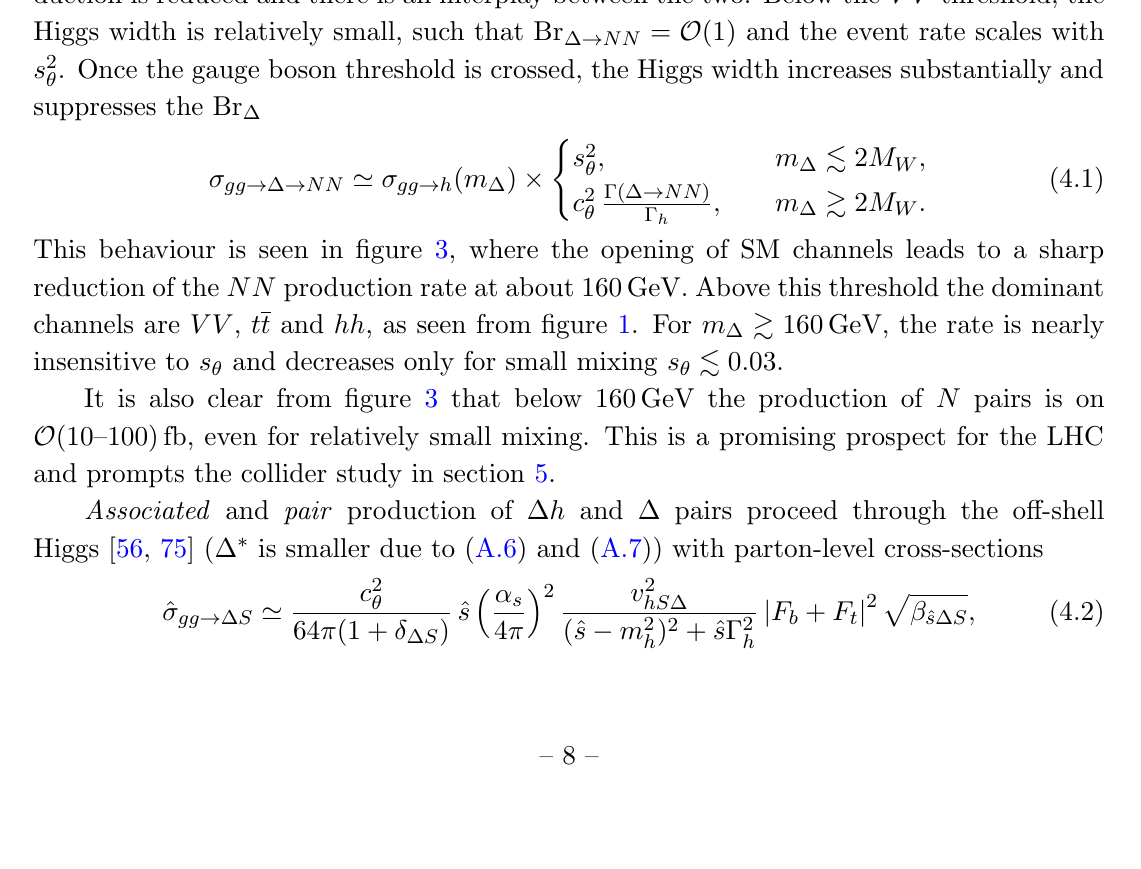
Figure 3 . Left: production cross-section of heavy Majorana neutrino pairs via (cid:1) gluon fusion. Colors correspond to di(cid:11)erent masses of N , ranging from 10 to 200 GeV. Right: production of four N s in gg ! h ! (cid:1)(cid:1) for di(cid:11)erent masses of N down to 5 GeV. In both plots, 17 TeV ; r ++ = 0 : 3 and for each m N the values of s (cid:18) considered are 5, 10 and 20% with respective dotted, dashed and solid